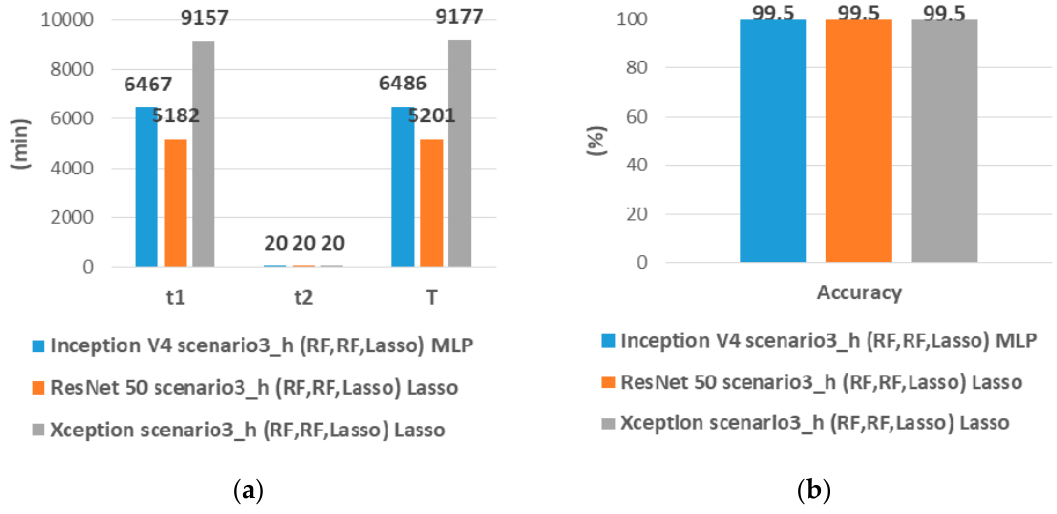
Figure 9. ( a ) Training data collection time t 1 , training time t 2 , and total time T of scenario 4-2, ( b ) For each CNN model, the highest processing prediction accuracy of scenario 4-2.